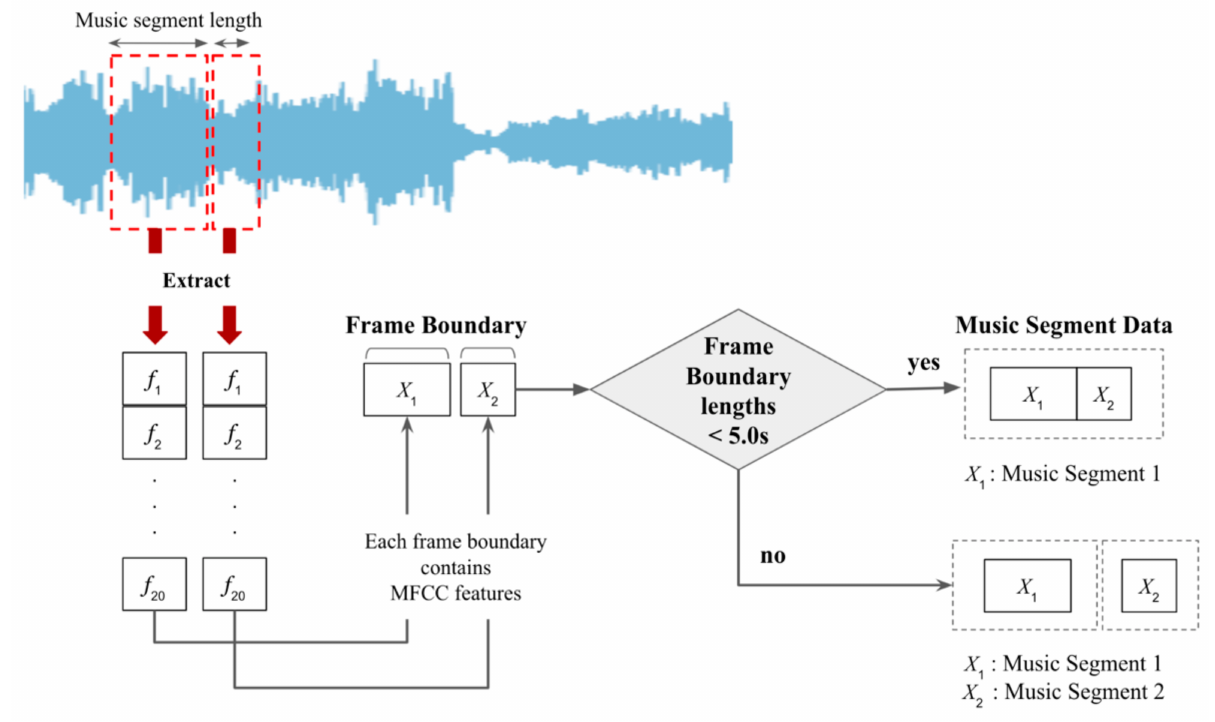
Figure 6. Overview of Music Segment Short Term Clustering